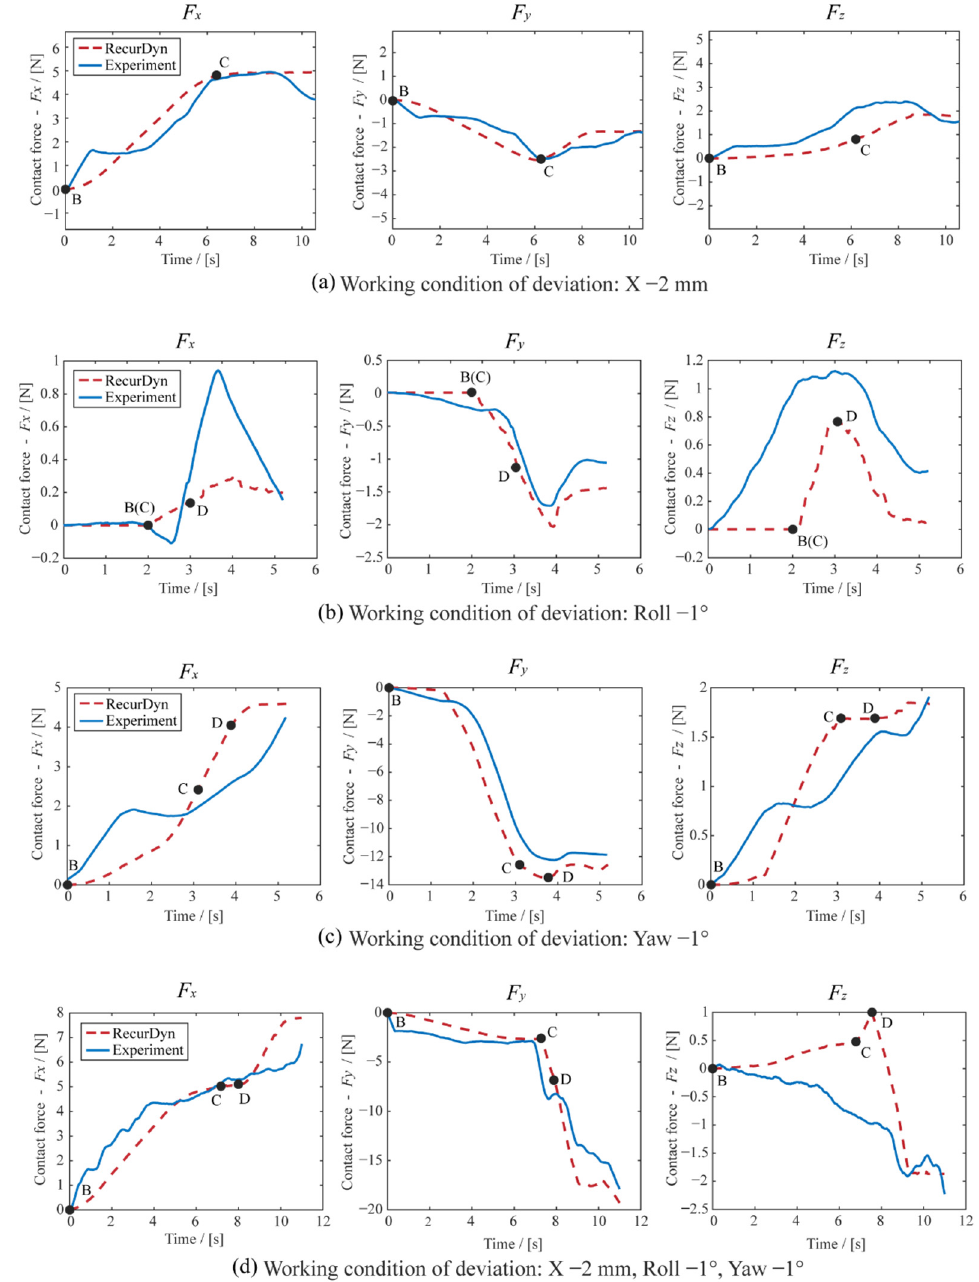
Figure 23. Results of contact forces by simulation and experiment: ( a ) (X − 2 mm), ( b ) (Roll − 1 ◦ ), ( c ) (Yaw − 1 ◦ ), ( d ) (X − 2 mm, Roll − 1 ◦ , Yaw − 1 ◦ ). The three subplots of each condition are the curve of component forces of contact force, Fx , Fy , and Fz and time, from left to right; the points B, C, and D represent the corresponding key positions of docking in Figure